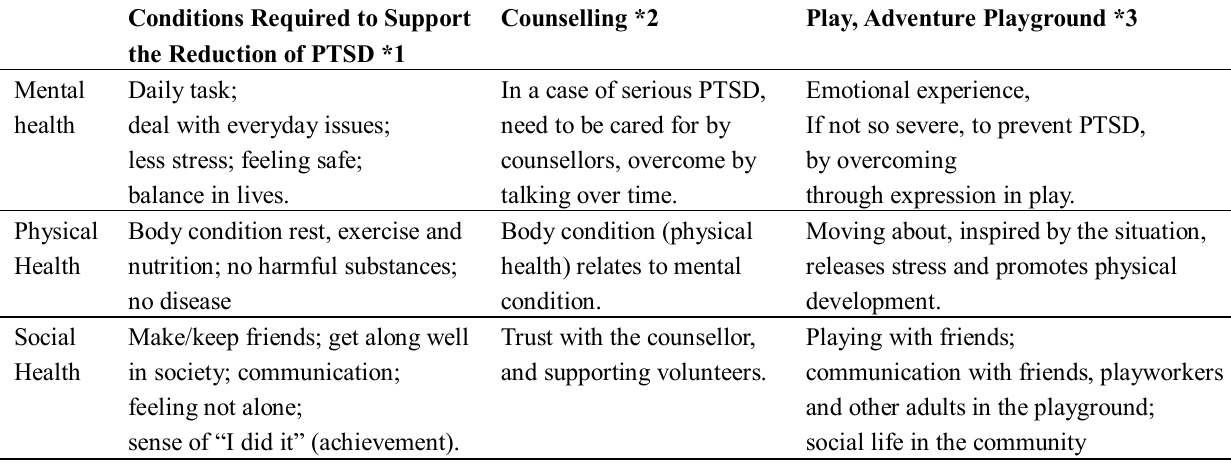
Table 1. Health triangle and tasks for anti